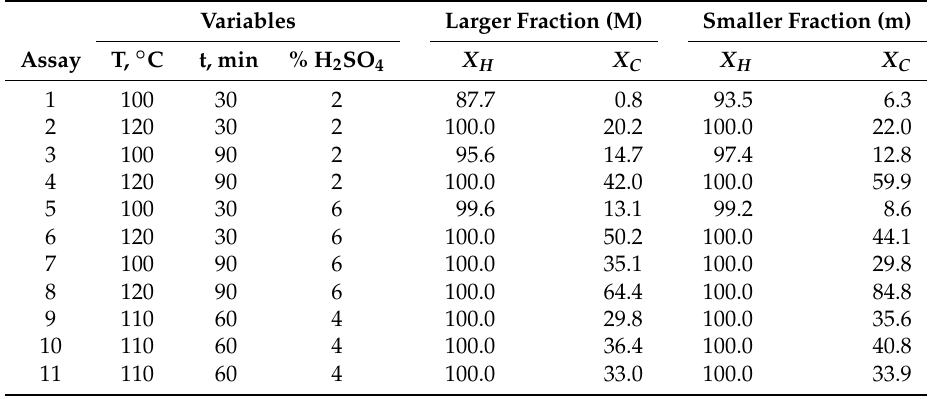
Table 2. Fractional conversions (%) in hemicellulose, X H , and cellulose, X C .